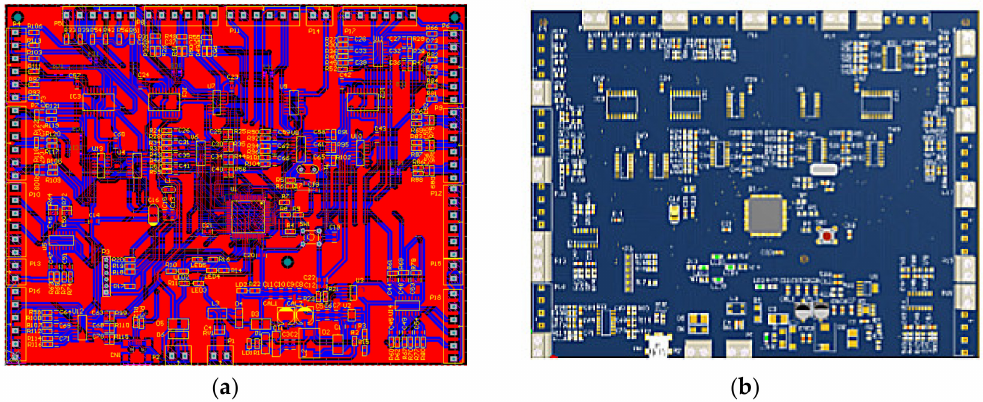
Figure 13. Design of the PCB (Printed Circuit Board) layout: ( a ) 2D, ( b ) 3D for the main board